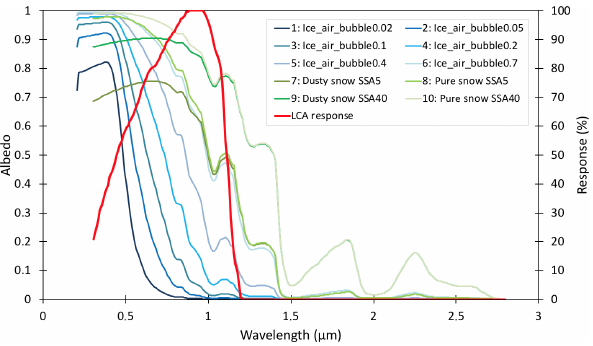
Figure 3. Semi-infinite diffuse beam albedo of pure ice as a func- tion of the effective air bubble radius (mm) with a constant effective bubble concentration n (cid:48) e = 0 . 3mm − 3 . Here 0.3mm − 3 is the mean bubble concentration determined from 28 Greenland and Antarc- tica ice core samples (Gardner and Sharp, 2010); the semi-infinite diffuse beam albedo of dusty and pure snow is from DISORT mod- eling with or without dust and with a specific surface area (SSA) equal to 40 or 5m 2 kg − 1 (Stamnes et al., 1988; Carmagnola et al., 2013). The red line shows the LCA response in